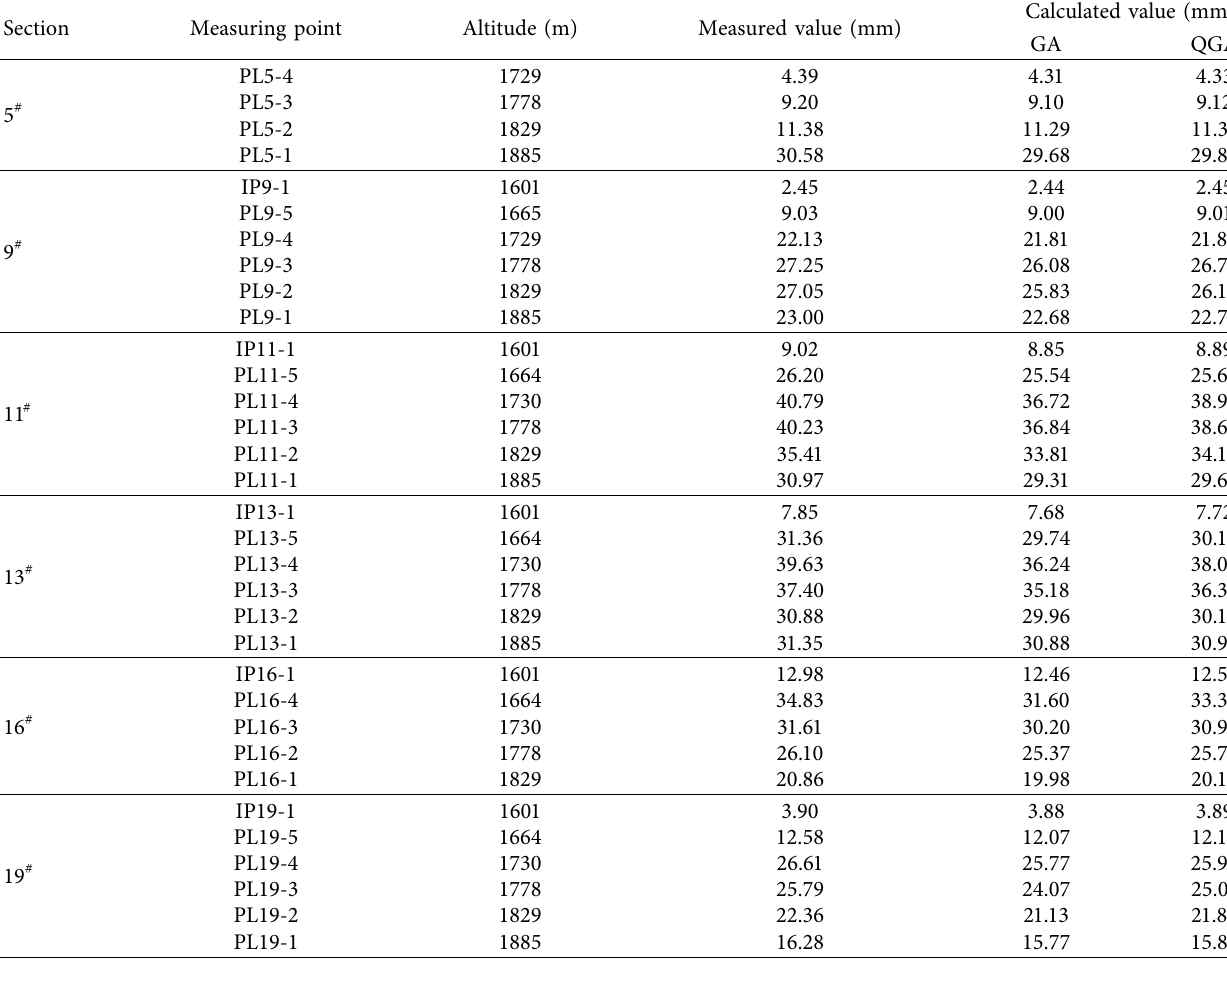
Table 3: Comparison of calculated and measured displacement values of the dam sections’ measure points under the water level of